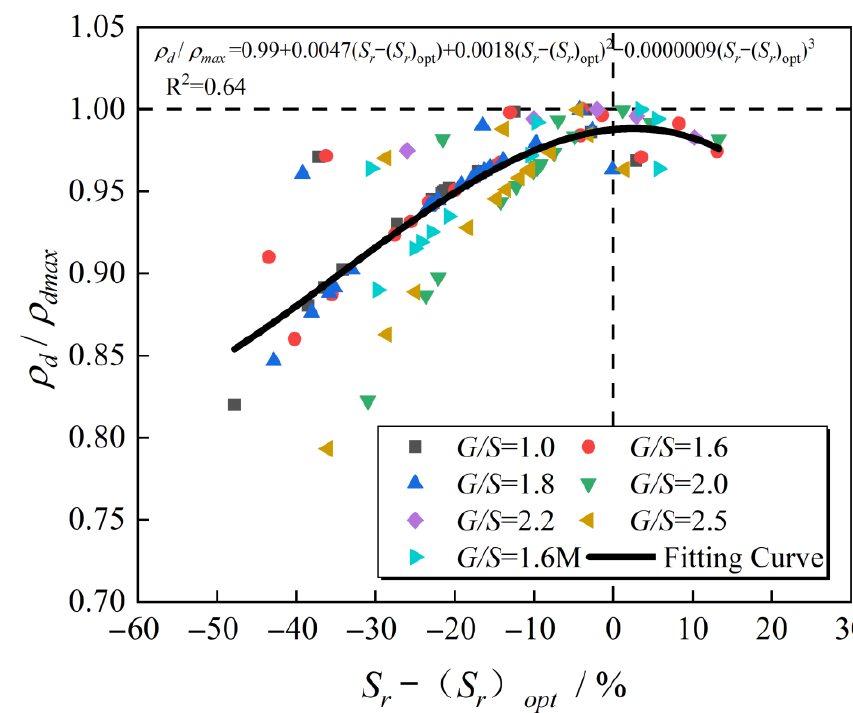
Figure 19. The unified compaction curve of UPAB specimens.